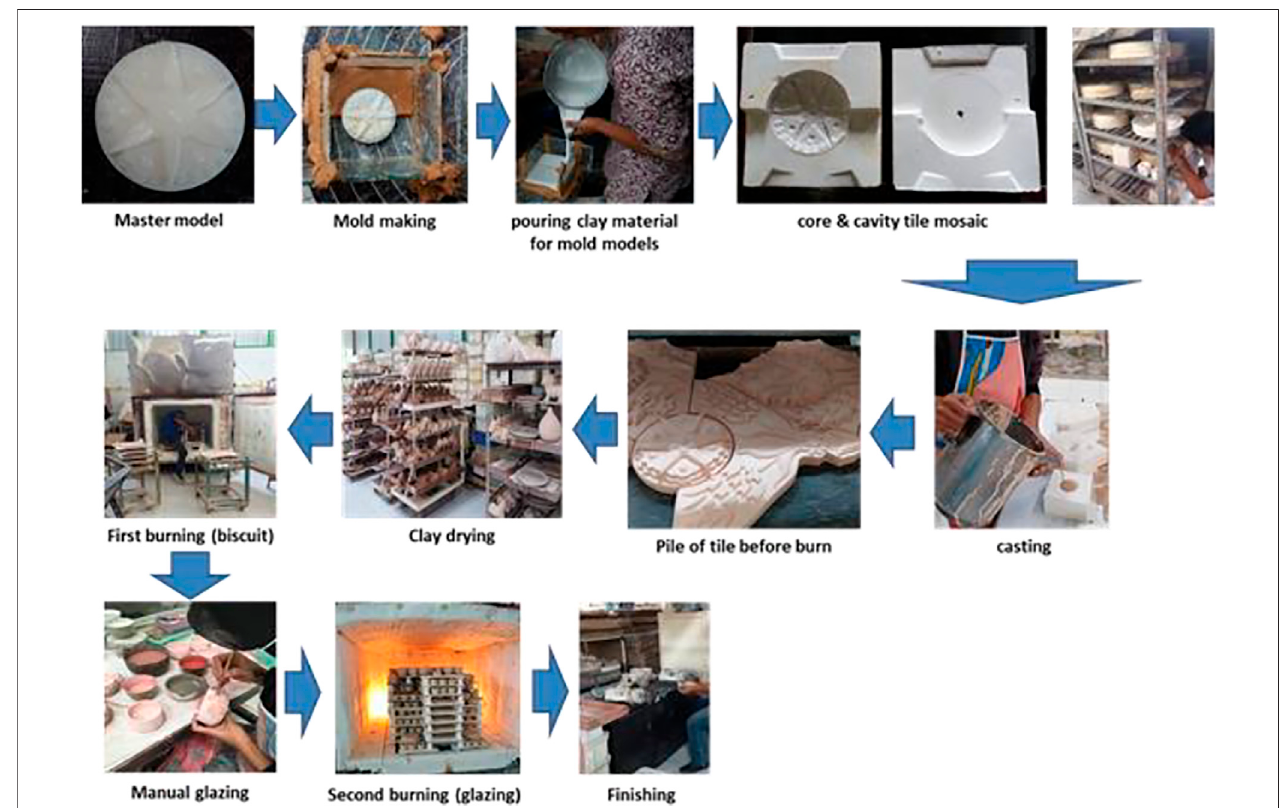
FIGURE 4 | General stages of IGP/IBM ceramic tile fabrication in an Indonesian ceramics factory.